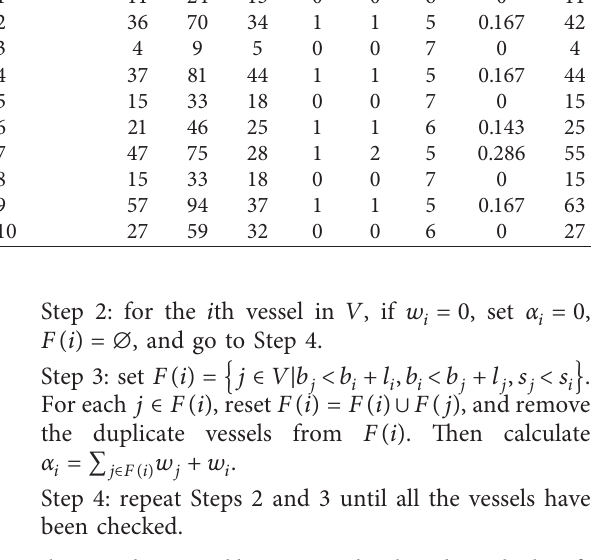
Table 3: Calculation of starting times for example instance. Vessel